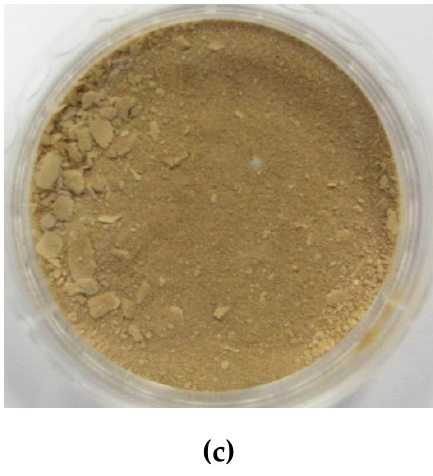
Figure 1. Photographs of ( a ) RH, ( b ) OL, and ( c ) CEL.